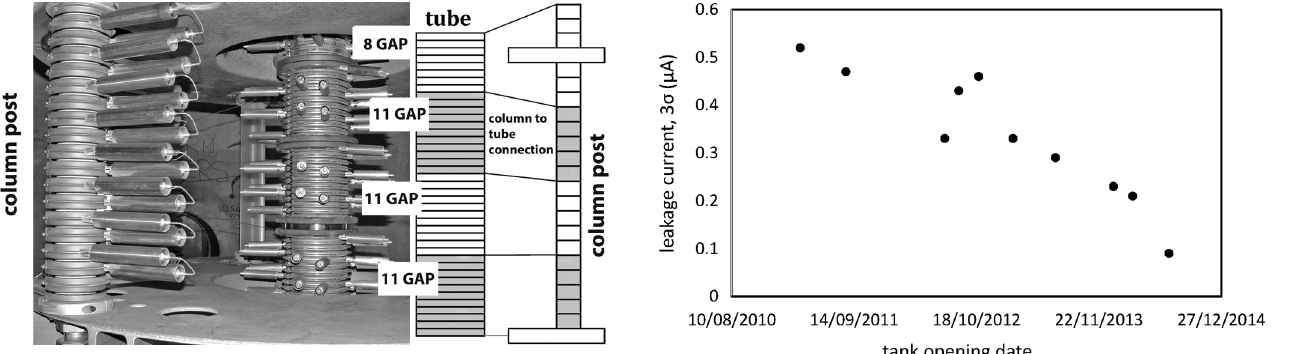
FIG. 3. Standard exit high voltage test result variation con- ducted on eleven gap tubes over the last few years on the ANU ’ s 14UD electrostatic